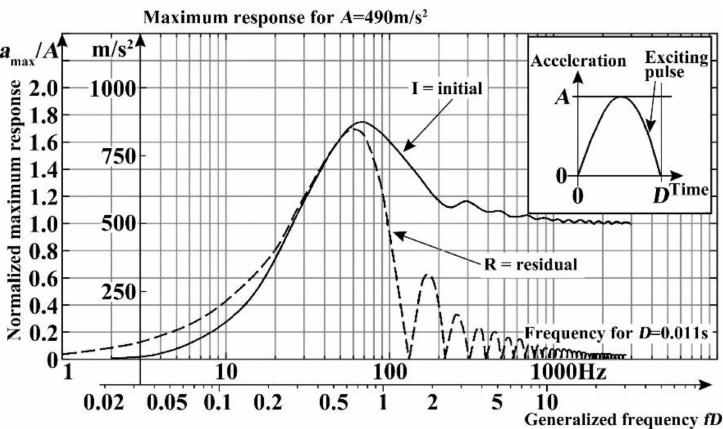
Figure 7. Shock response spectrum of half-cycle sine shock pulse (amplitude is 50 g and duration is 11 ms). The generalized frequency axis and the normalized maximum response axis are located below the frequency axis, and left of the maximum response axis, respectively. The shock response spectrum of normalized coordinate can be used to convert the half-cycle sine shock response spectrum of di ff erent A and D values. The converted expression